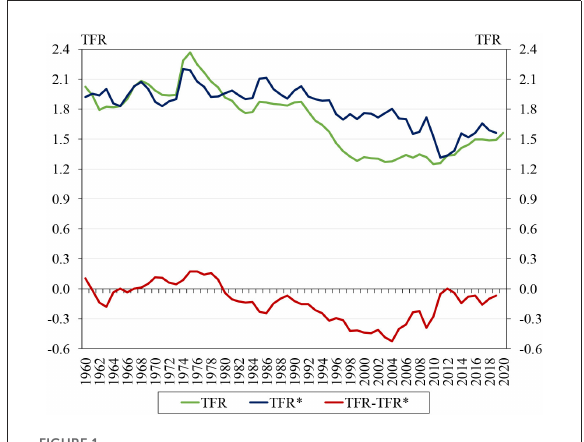
FIGURE1 Evolution of the total fertility rate, the tempo-adjusted fertility rate, and the difference between the two, 1960–2020. Source: HFD (2022), authors’ editing. TFR, total fertility rate; TFR * , tempo-adjusted total fertility